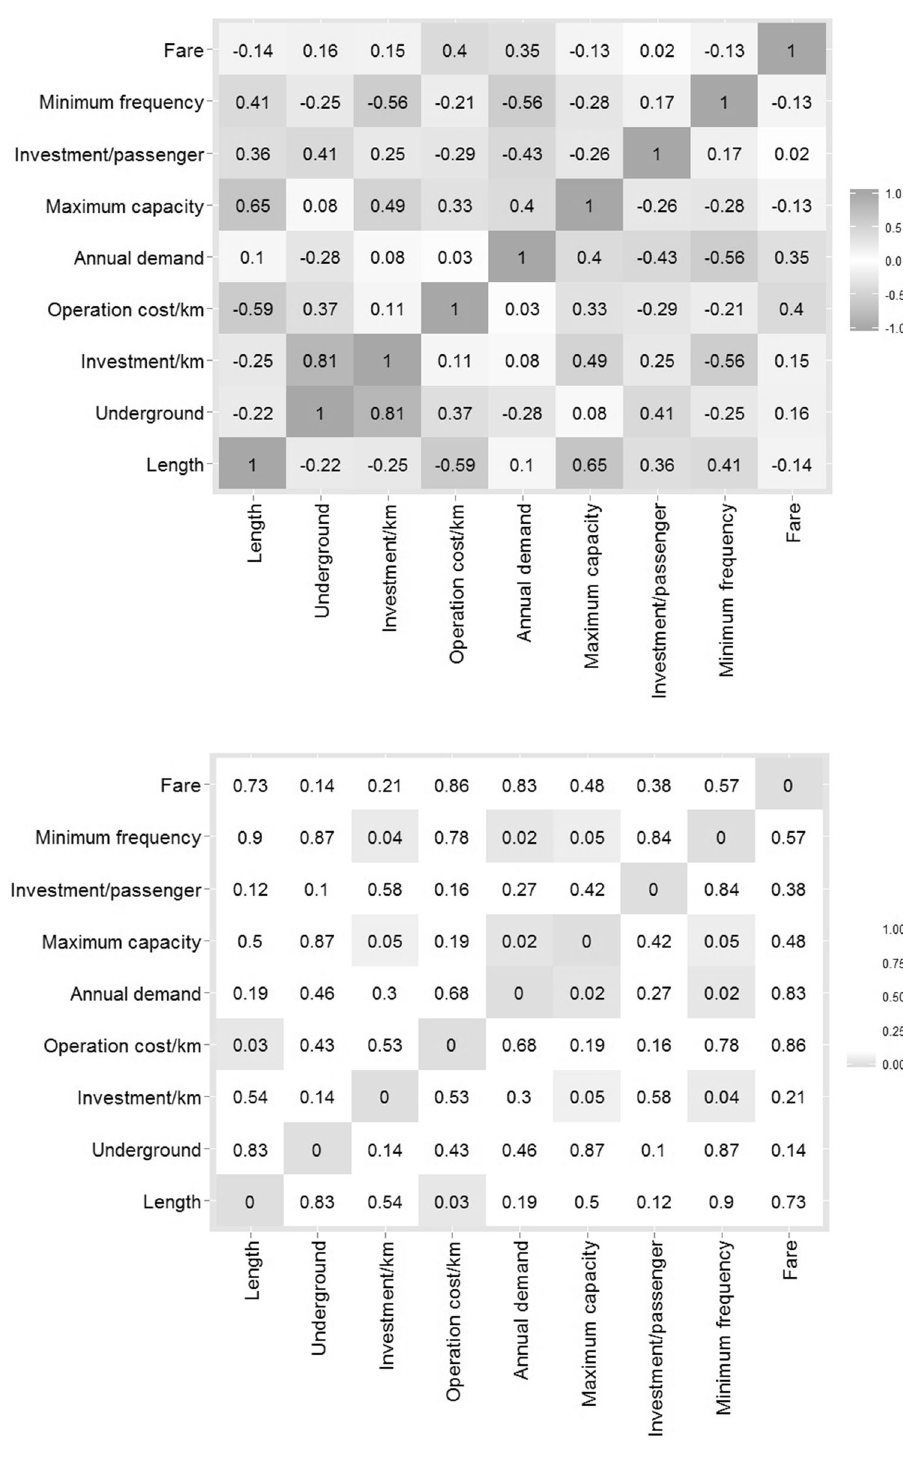
Fig. 2 Heat map of correlations between nontype of financing variables